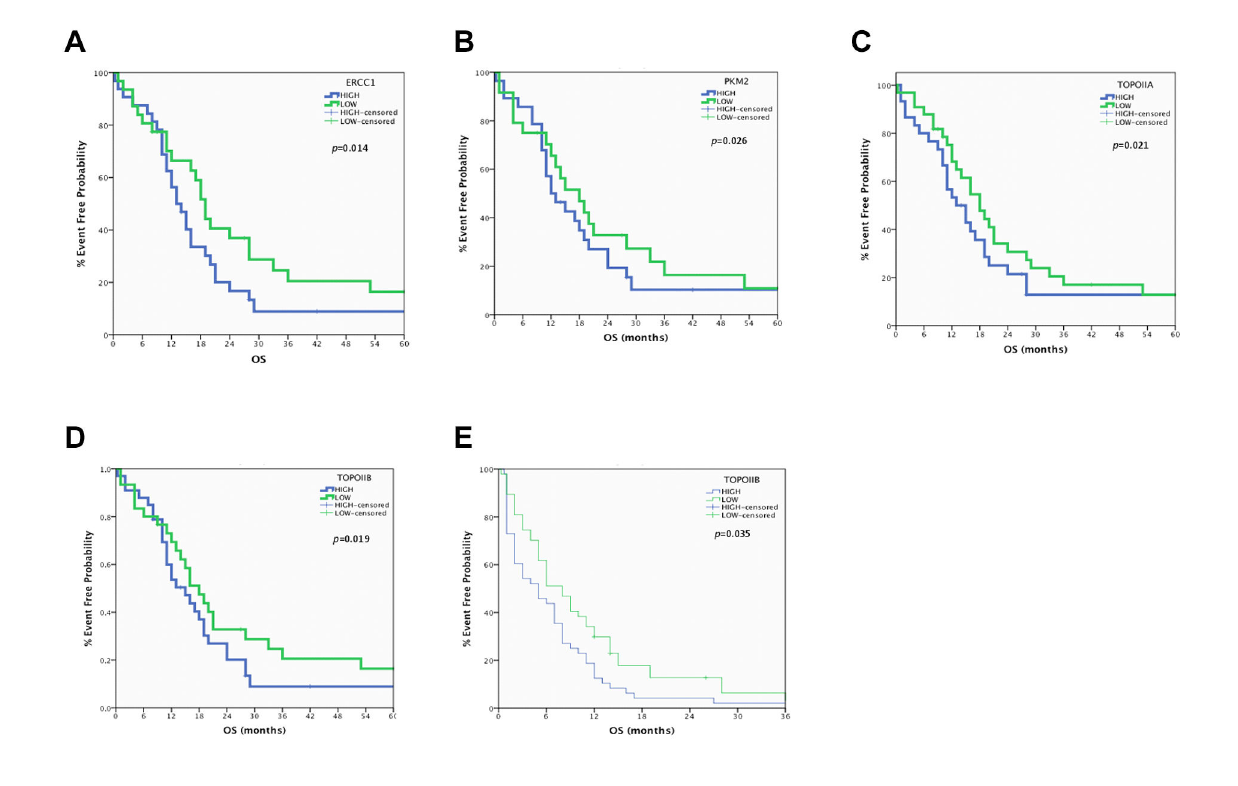
Figure 2. Overall Survival in Limited Stage-SCLC. A. ERCC1 mRNA levels and Overall Survival in Limited Stage-SCLC. B. PKM2 mRNA levels and Overall Free Survival in Limited Stage-SCLC. C. TOPOIIA mRNA levels and Overall Free Survival in Limited Stage-SCLC. D . TOPOIIB mRNA levels and Overall Free Survival in Limited Stage-SCLC. E. TOPOIIB mRNA levels and Overall Free Survival in Extended Stage-SCLC. doi: